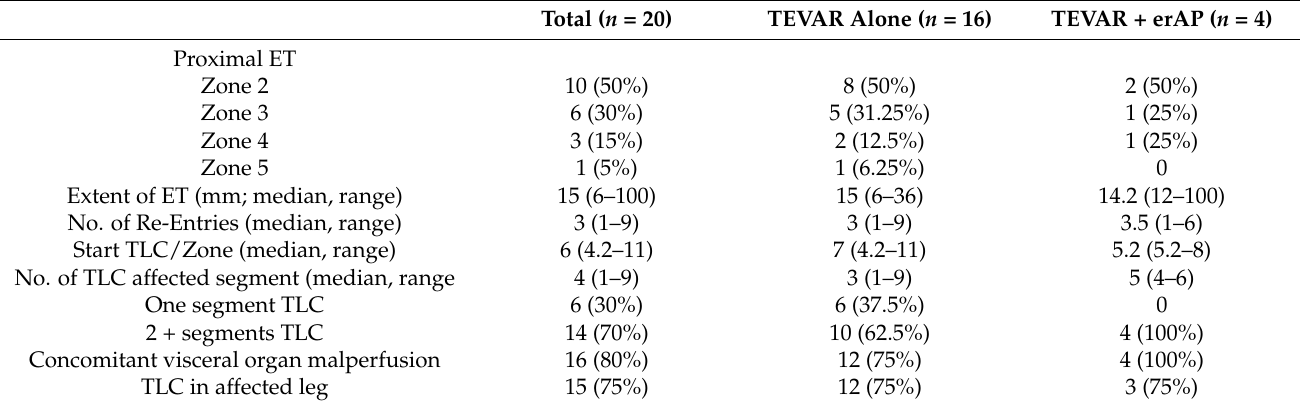
Table 4. Morphological data before